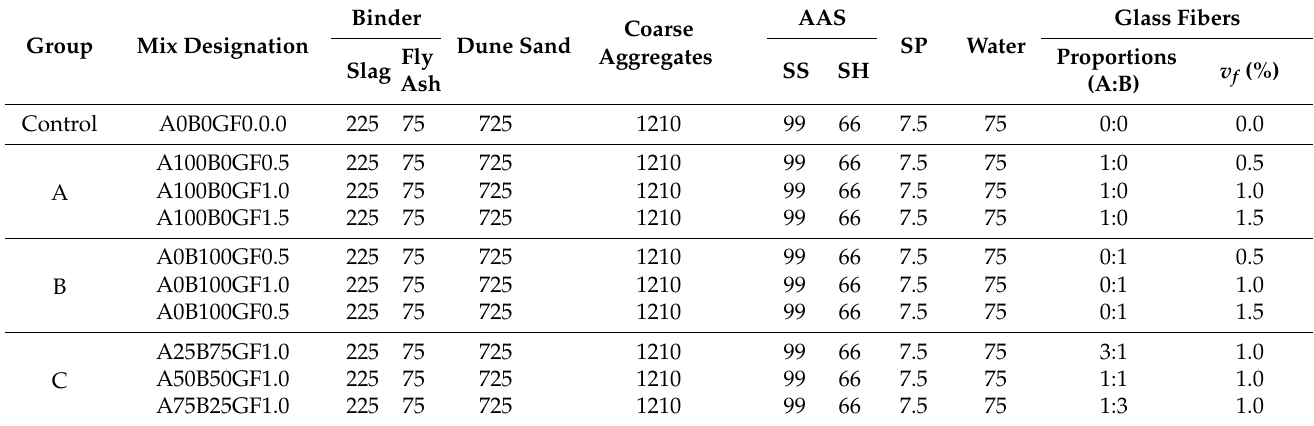
Table 4. Mixture proportions of geopolymer concrete mixes (kg/m 3